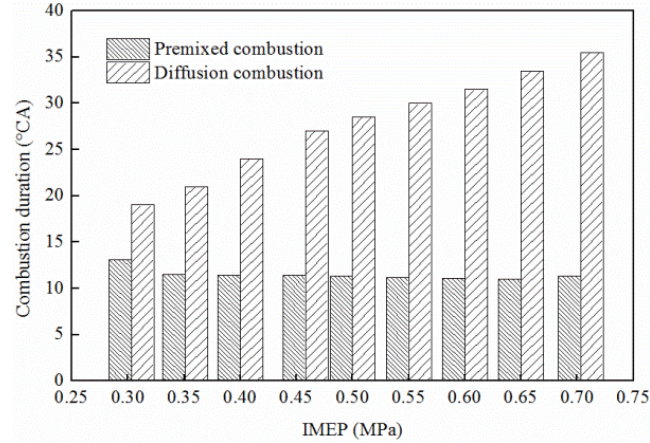
Figure 9. CD at different loads.